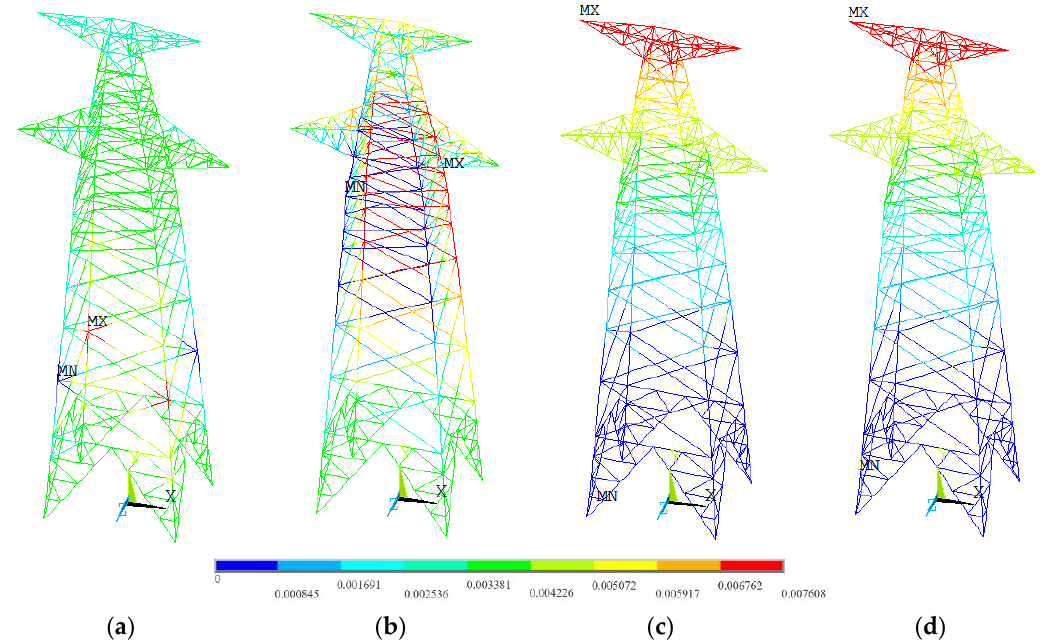
Figure 6. Displacement of the transmission tower in the first order vibration mode with settlement; ( a – c ) are the results in the X, Y and Z directions, respectively, and ( d ) is the sum vector result.